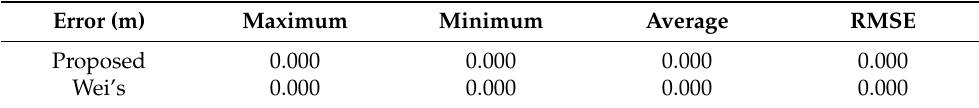
Table 2. The error of the elevation.